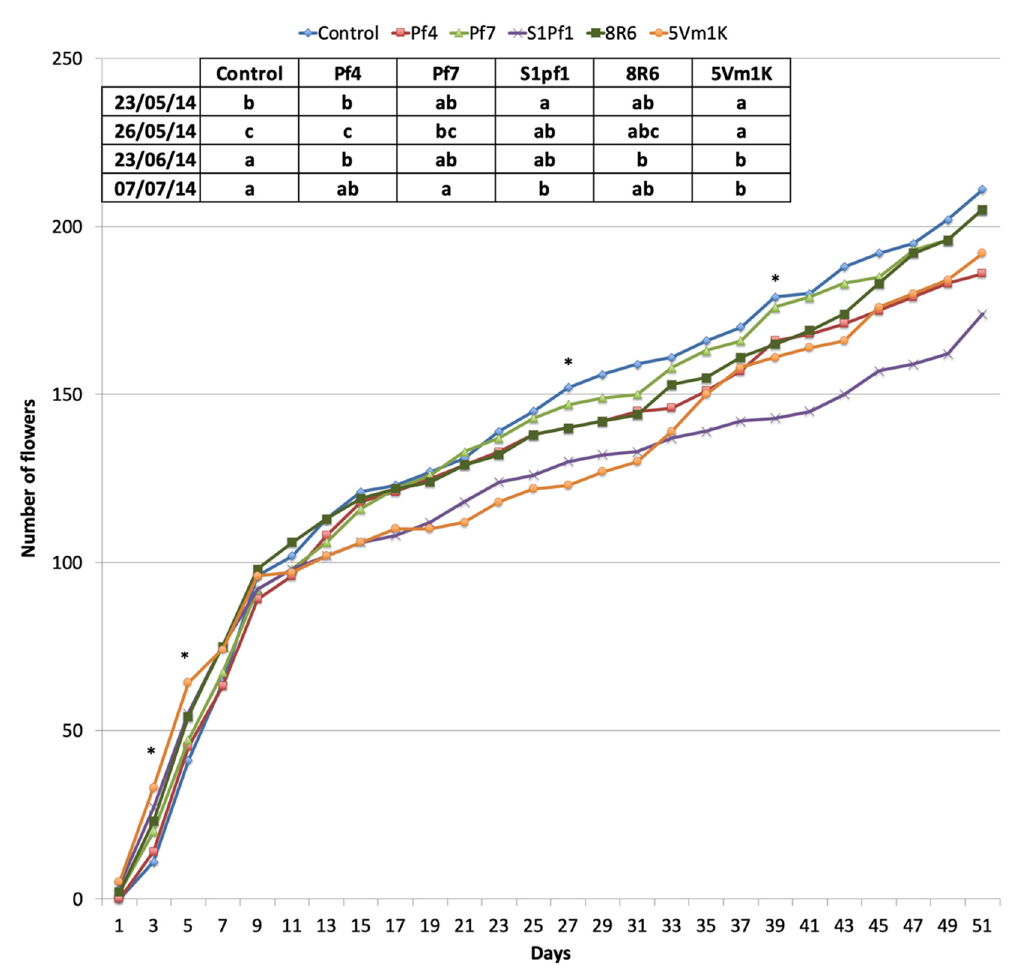
Figure 5. The number of female flowers produced by zucchini plants inoculated or not with the five PGPBs during two months of growth. The * indicates a sampling time where significant differences among the treatments were observed; in the table, the different letters indicate significant differences among the treatments according to ARTANOVA followed by a permutation test or to the Kruskal–Wallis test followed by the Dunn test ( p < 0.05).